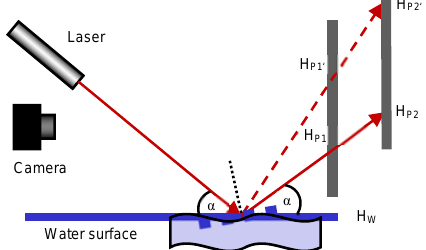
Figure 5: Setup with two projection planes